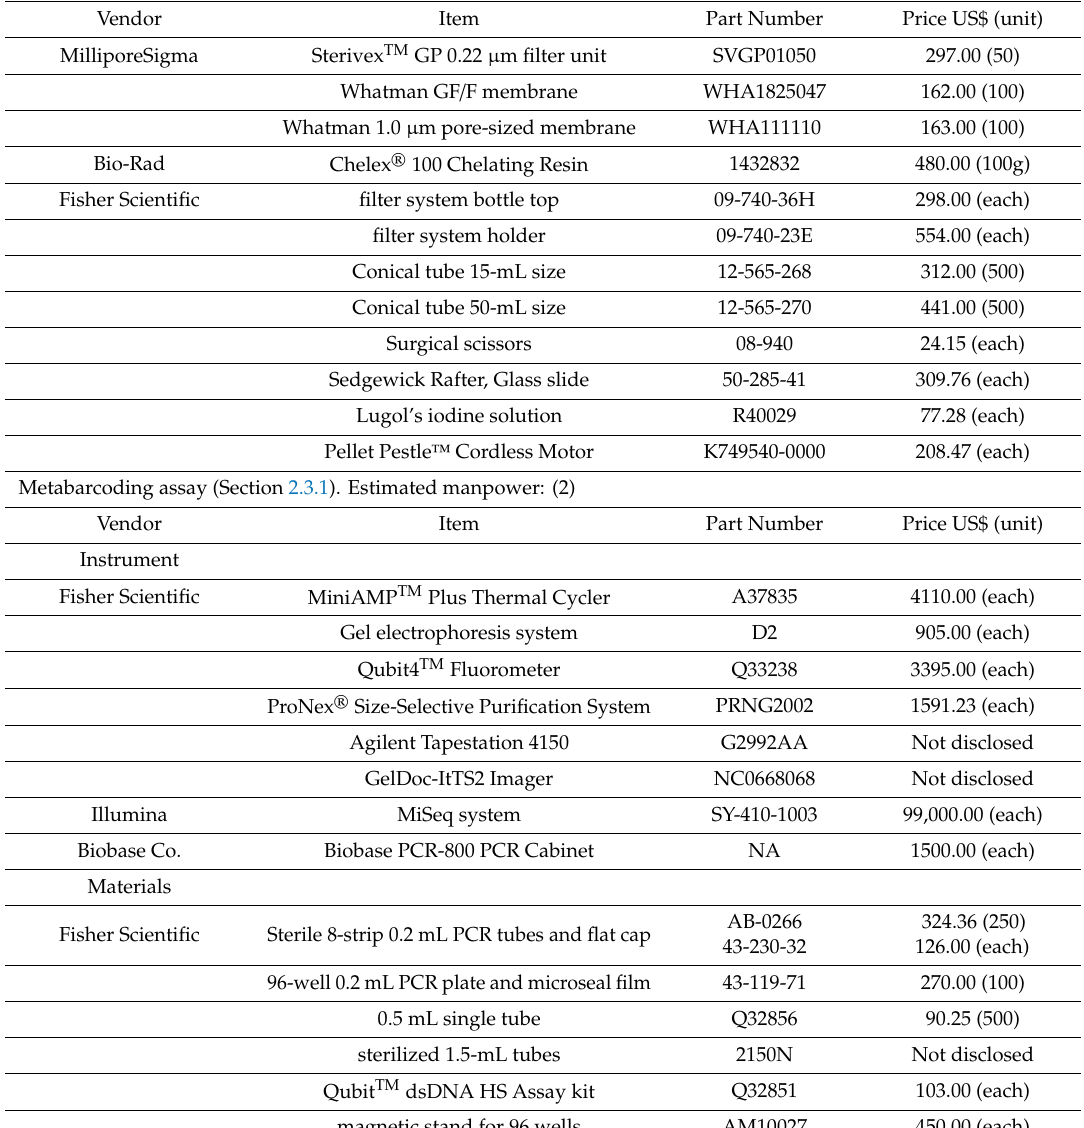
Table A1. Materials, reagents, instrument